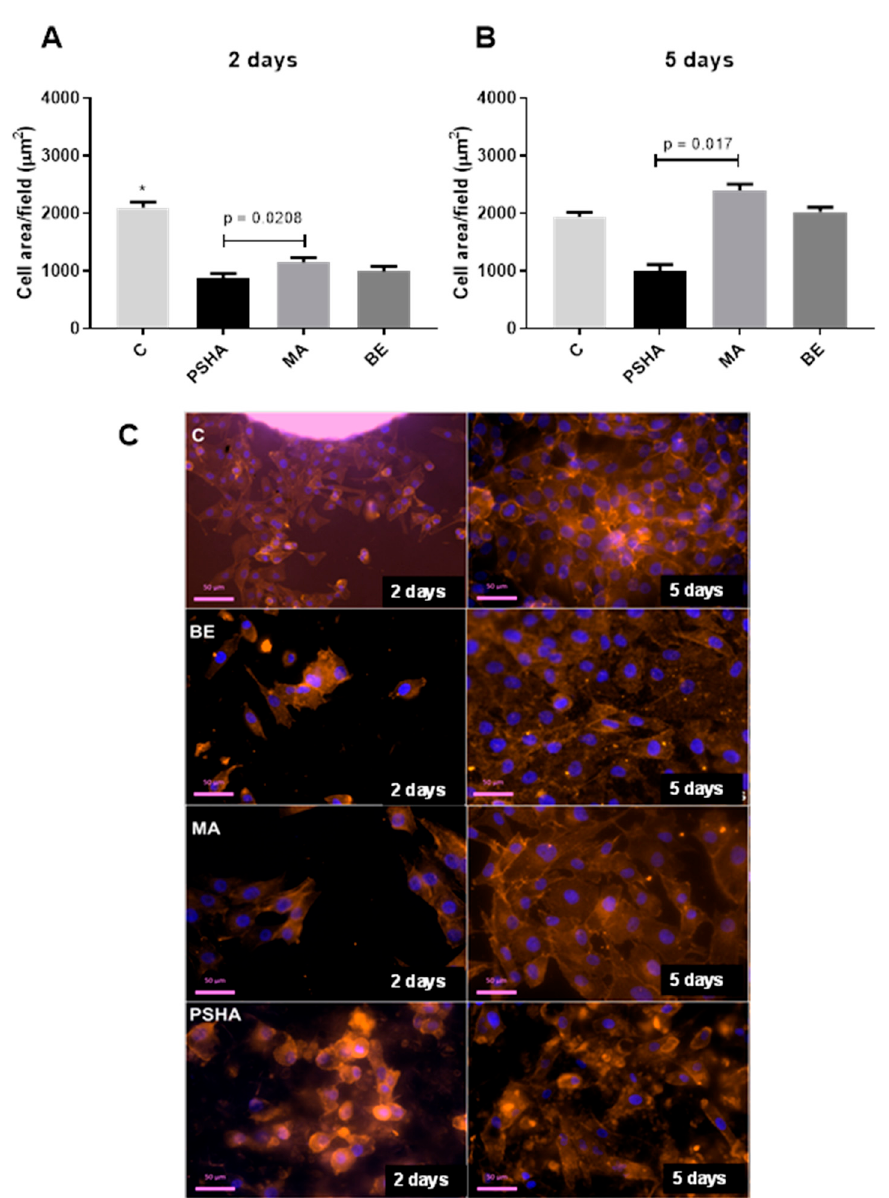
Figure 8. Cellular area measured in µm using Image-Pro Plus software for 2 days ( A ) and 5 days of exposure ( B ). On the second day, the MA group showed a difference compared to the PSHA group with p = 0.0208 and the C group showed a significant difference in relation to all groups (*). ( C ) vs. PSHA p < 0.0001, C vs. MA p = 0.0051, C vs. BE p < 0.0001. On the fifth day, the difference was between the MA and PSHA groups with p = 0.017. Panel C shows examples of the fields collected for each group for the analysis at 2 and 5 days. Bars indicate mean ± SEM of three independent tests with three biological replicates